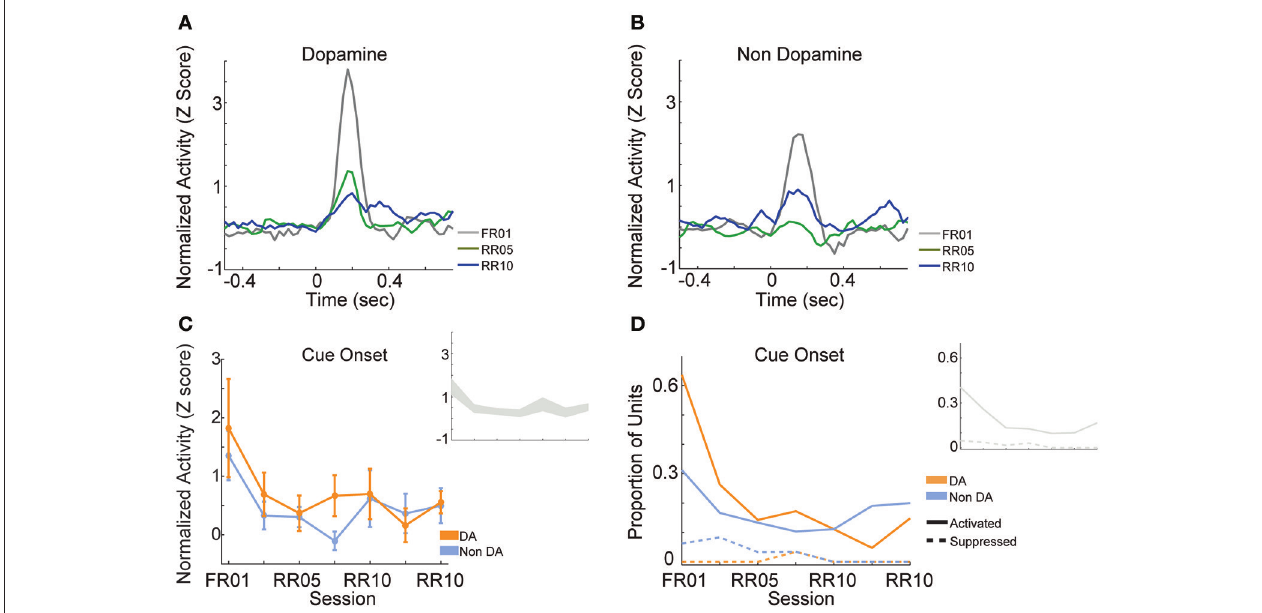
FIGURE 8 | VTA responses to cue onset. Normalized mean (A) dopamine and (B) non-dopamine responses to cue onset (time = 0). Data are depicted for the FR01 session, the final RR05 session, and the final RR10 session. (C) Mean ± SEM responses evoked by cue onset ( + 0.05 to + 0.3 s) in all groups of neurons and sessions. Data are depicted separately for all putative dopamine and non-dopamine neurons. Responses were greatest in session 1 and significantly less in subsequent sessions, with no difference by neuron type. Inset depicts data from all VTA neurons plotted without respect to neuronal classification. (D) Proportion of neurons activated (solid lines) or suppressed (dashed lines) by cue onset. Data are depicted across all sessions for putative dopamine and non-dopamine neurons. The proportion of activated dopamine neurons, but not non-dopamine neurons, decreased in later sessions. Inset depicts data from all VTA neurons plotted without respect to neuronal classification.